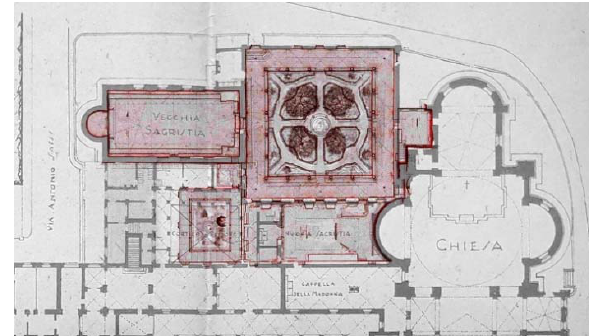
Figure 10. A comparison between the current survey (red) and the drawing of a survey before the second world war: the Chiostro del Priore in the old floorplan is larger and morphologically different.